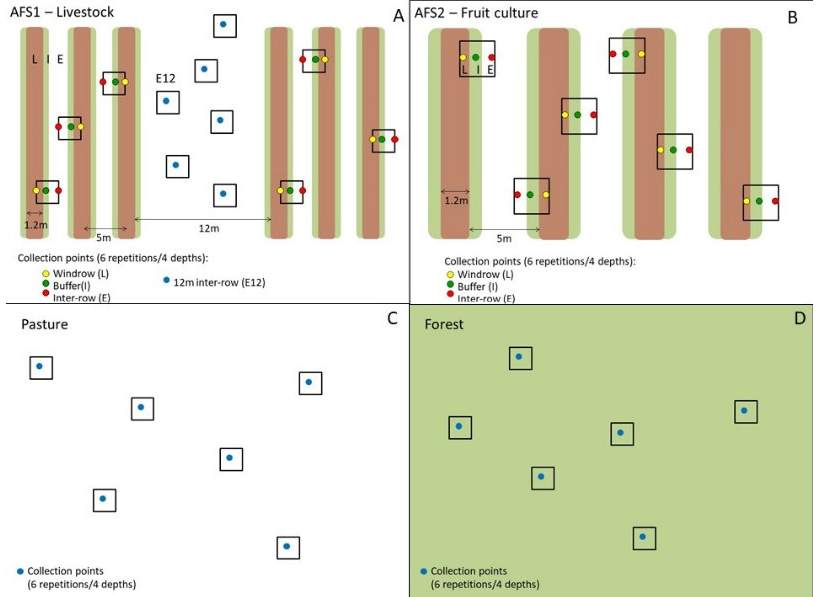
Figure 2. Representative scheme of soil collection performed for different land use systems with emphasis on sampling regions. ( A ) AFS1—agroforestry system developed for livestock, ( B ) AFS2—agroforestry system developed for fruit culture, ( C ) Pasture—pasture system, and ( D ) Forest—forest fragment in natural regeneration.